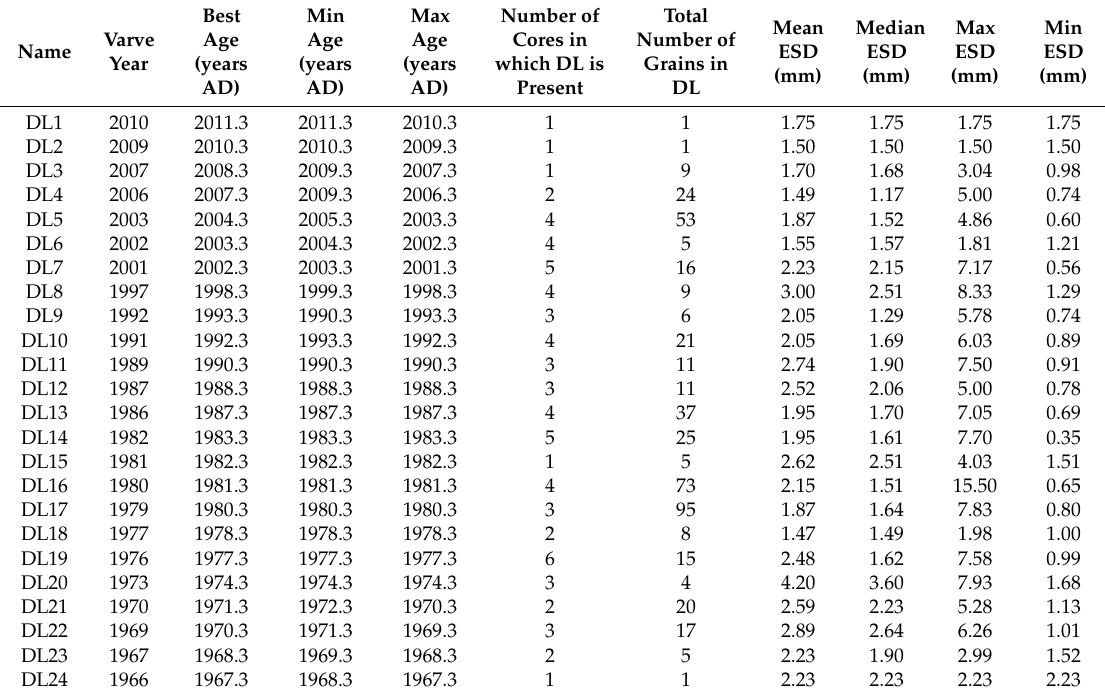
Table 1. Characteristics of debris laminae in the cores, their ages and physical properties of the grains (DL = debris lamina, ESD = equivalent spherical diameter).